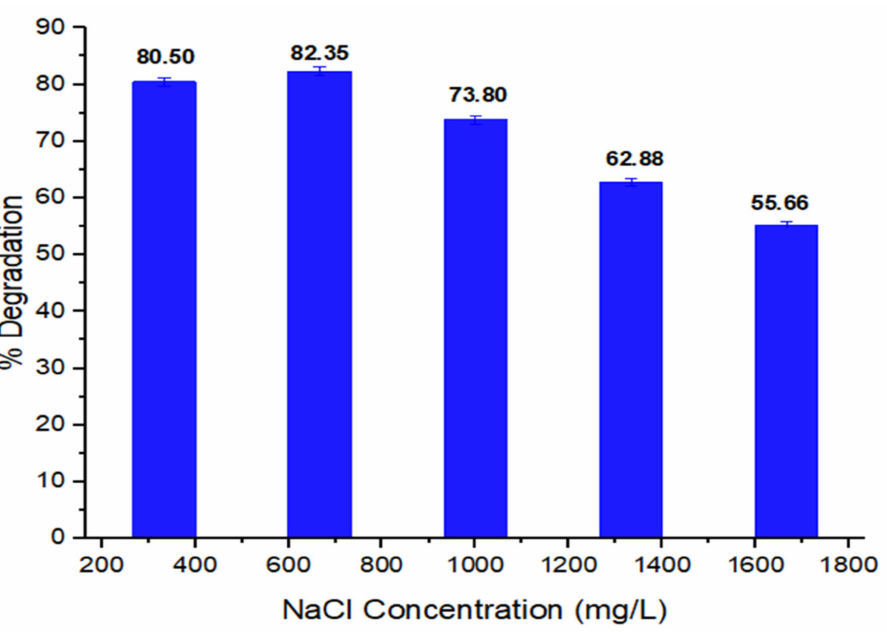
Figure 9. Effect of Sodium Chloride Concentration (mg/L) on Dye Basic Orange 2%